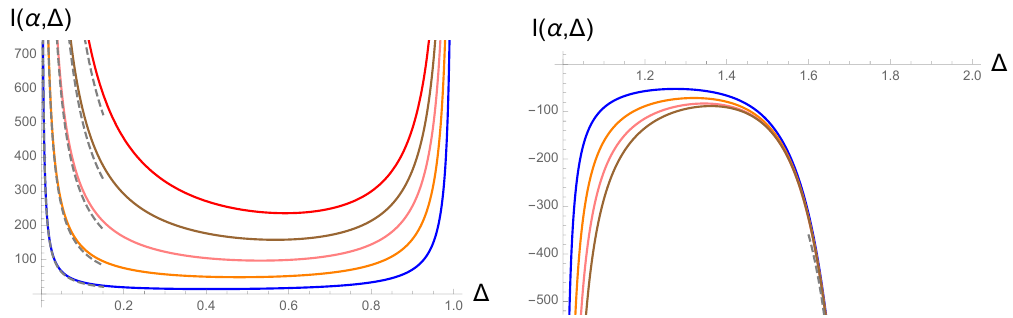
Figure 10 . (Left) I ( (cid:11); (cid:1)) for (cid:11) = 0 : 2 ; 0 : 4 ; 0 : 6 ; 0 : 8 ; 1 from the bottom up between 0 < (cid:1) < 1. In gray dashed the known asymptotic 2(2 (cid:25)(cid:11) ) 2 = (cid:1) as (cid:1) ! 0.